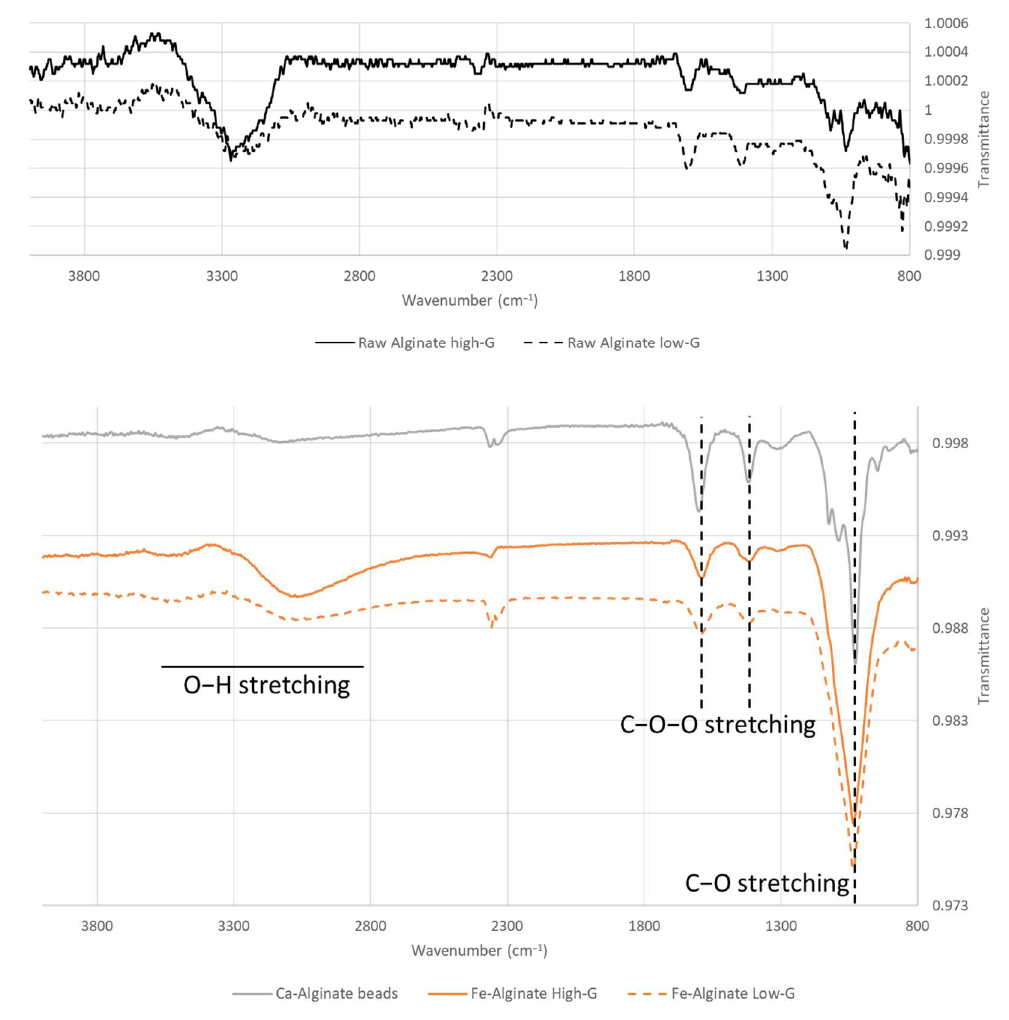
Figure 4. FTIR spectra of raw alginate powders, Ca-Alginate and Fe-Alginate beads for low and high G-content sodium alginate references.